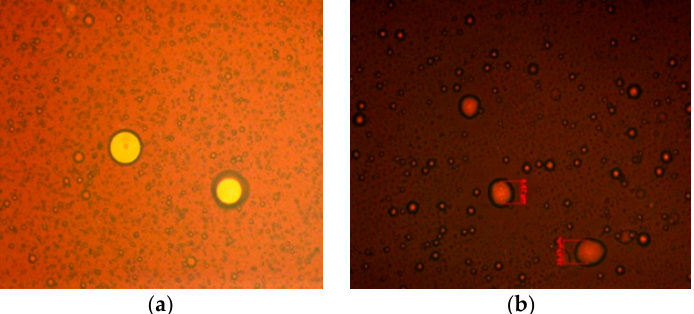
Figure 12. Emulsions observed in the micromodel experiments during nanofluid flooding processes [34].